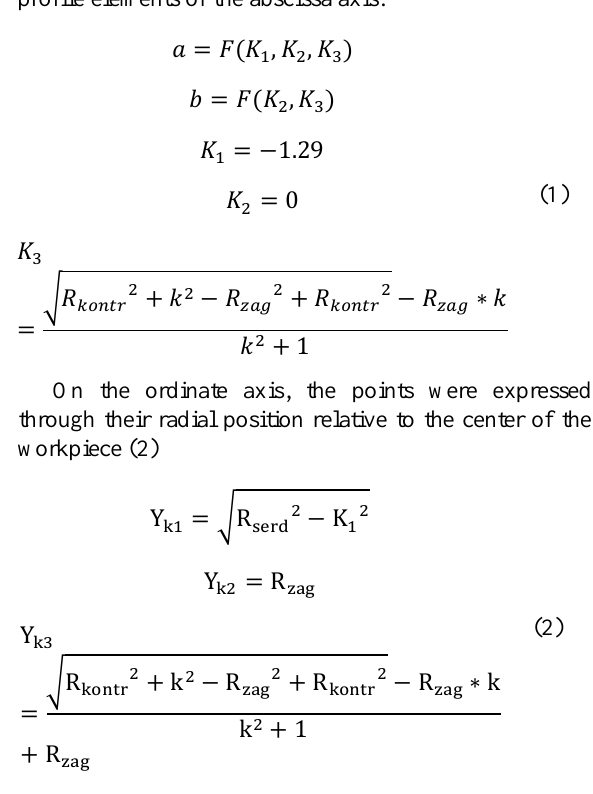
Fig. 1. Shape model of toroidal section end mill’s rake surface. where are the characteristics of the rake surface profile on the plane, considering the value of the rake angle in the cutter radial section (Fig. 2). 𝑋𝑋𝑋𝑋𝑋𝑋